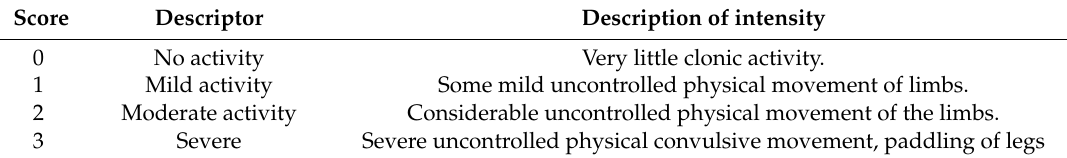
Table 1. Subjective scoring system used to assess post-stun/kill movement based on the level of spinal reflex activity, ranging from 0 (no clonic activity post-stun) to 3 (severe uncontrolled physical